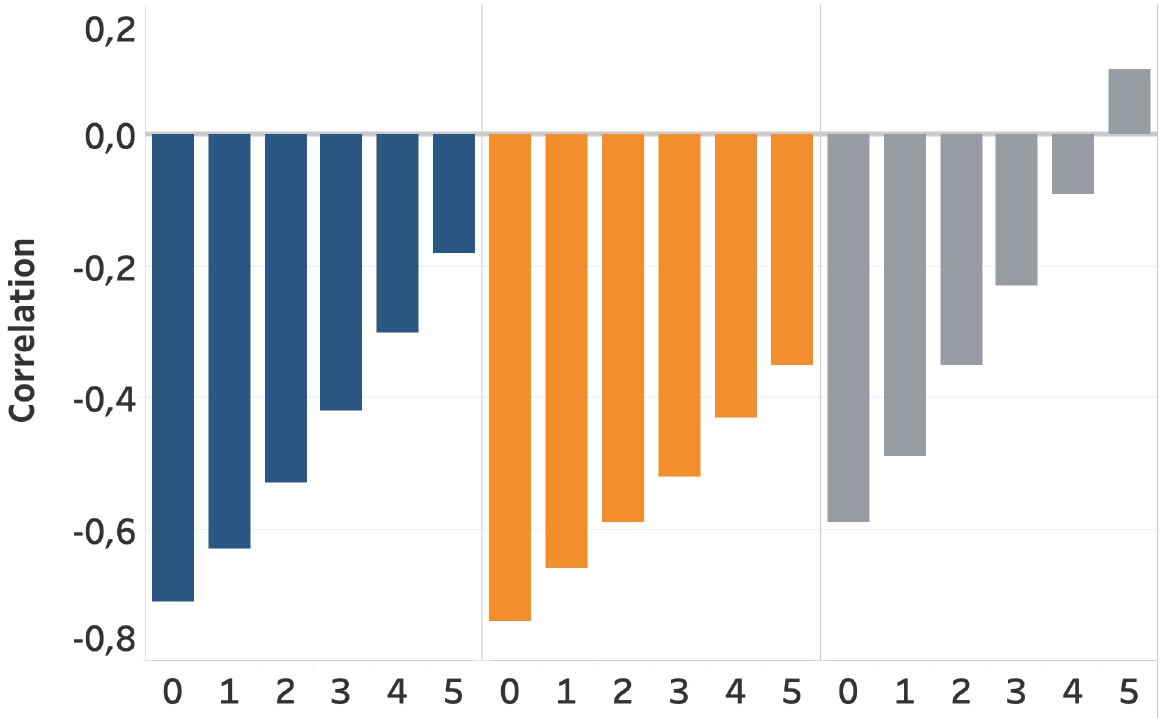
Fig 11. Pearson correlation coefficient of traffic, flights, and stocks, with the lagged corona deaths variable on the x -axis. It presents the correlation between the target variable and the corona deaths of x weeks earlier. Traffic (blue), Flights (orange), and Stocks (grey).